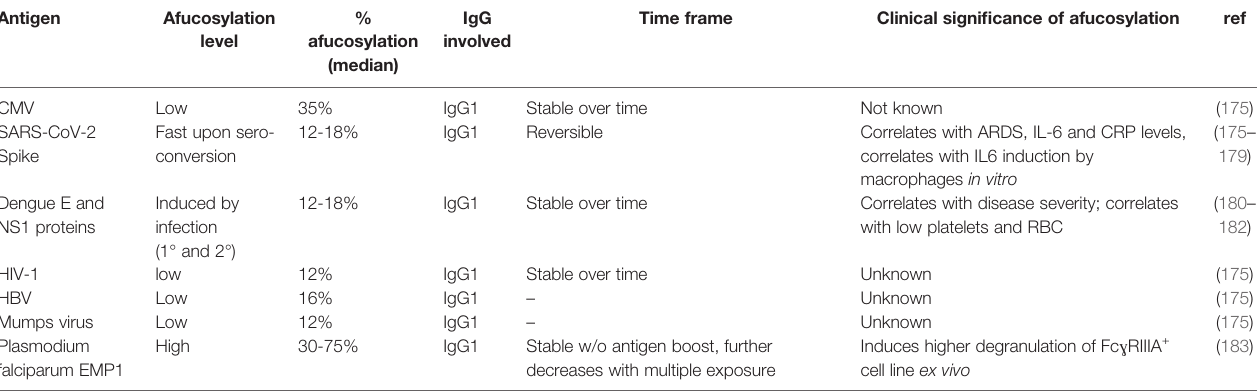
TABLE 3 | Examples of modulation of Fc core fucosylation of antigen-speci fi c IgGs in infectious